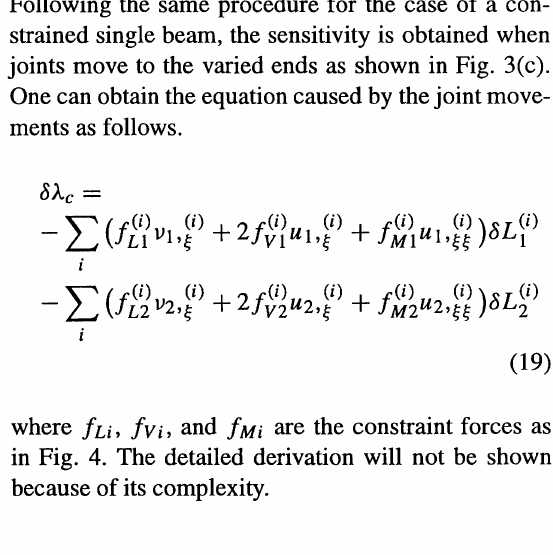
FIGURE 4 Two beams connected by joint